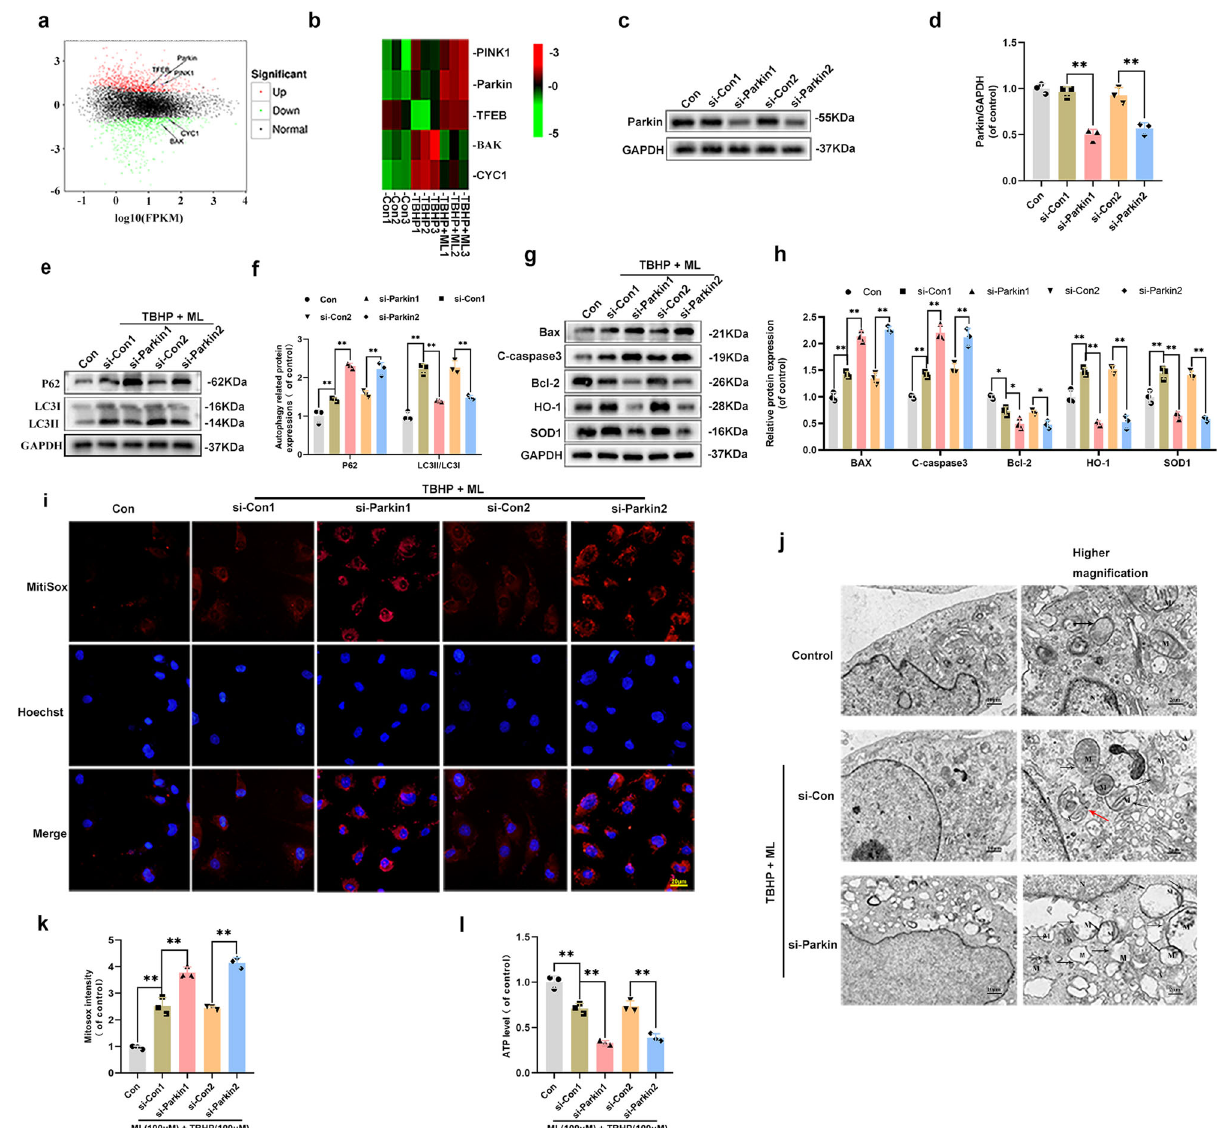
Fig. 4 ML promoted mitophagy by upregulating Parkin. a M-versus-A (MA) plot was shown the differential gene expression between TBHP and TBHP + ML groups. b Heatmap analyses of the key molecules differentially regulated in HUVECs in control, TBHP, and TBHP + ML groups based on transcriptome analysis. c , d The expression of Parkin was evaluated by western blots in HUVECs treated with si-RNA. e , f Western blot measured the expression level of LC3 and P62 after Parkin knockdown. g , h Expression and quanti fi cation of protein Bax, C-caspase3, Bcl-2, HO-1, and SOD1 were measured by western blot. i MitoSox staining was performed to detect the mitochondria ROS in HUVECs (bar: 20 μ m). j Detection of ultrastructure of mitochondria and autophagic change by TEM (×10,000 or 50,000) (Black arrow: swollen mitochondria with fractured cristae; Red arrow: autophagolysosome; M: mitochondria; A: autophagosome). k The fl uorescence intensity was quanti fi ed and demonstrated by a histogram. l ATP production in HUVECs was measured by an ATP detection kit and showed by a histogram. All experiments have been performed at least 3 times ( n ≥ 3). Data are presented as mean ± S.D. n = 3, ** P < 0.01, * P <